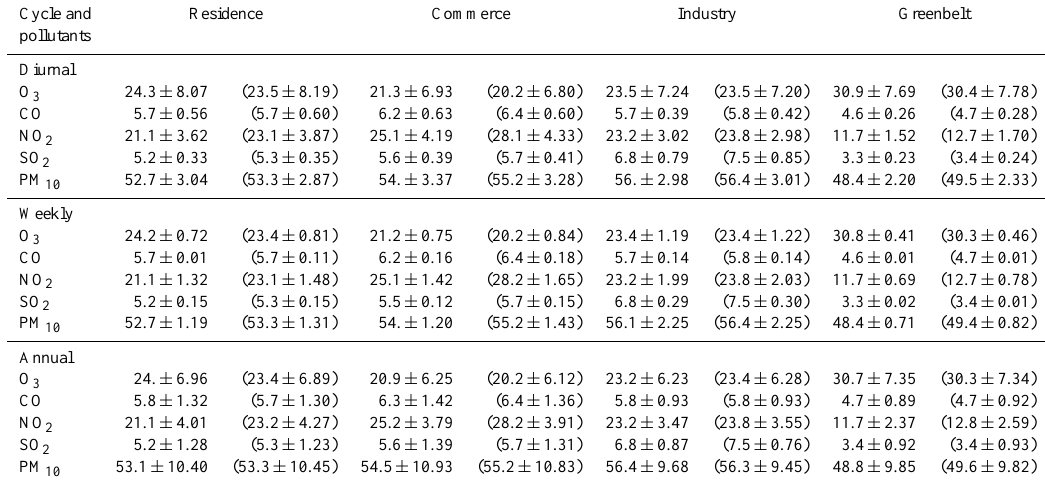
Table 6. The spatial mean and standard deviation of the surface air pollutant concentration averages (O 3 , CO, NO 2 , SO 2 , and PM 10 ) in the diurnal, weekly, and annual variations over South Korea during 2002–2013 in a 0.25 ◦ × 0.25 ◦ grid in terms of the four land-use types of MEK as follows: residence (R), commerce (C), industry (I), and greenbelt (G). Here the values in parentheses denote the mean and standard deviation in a 0.1 ◦ × 0.1 ◦ grid.